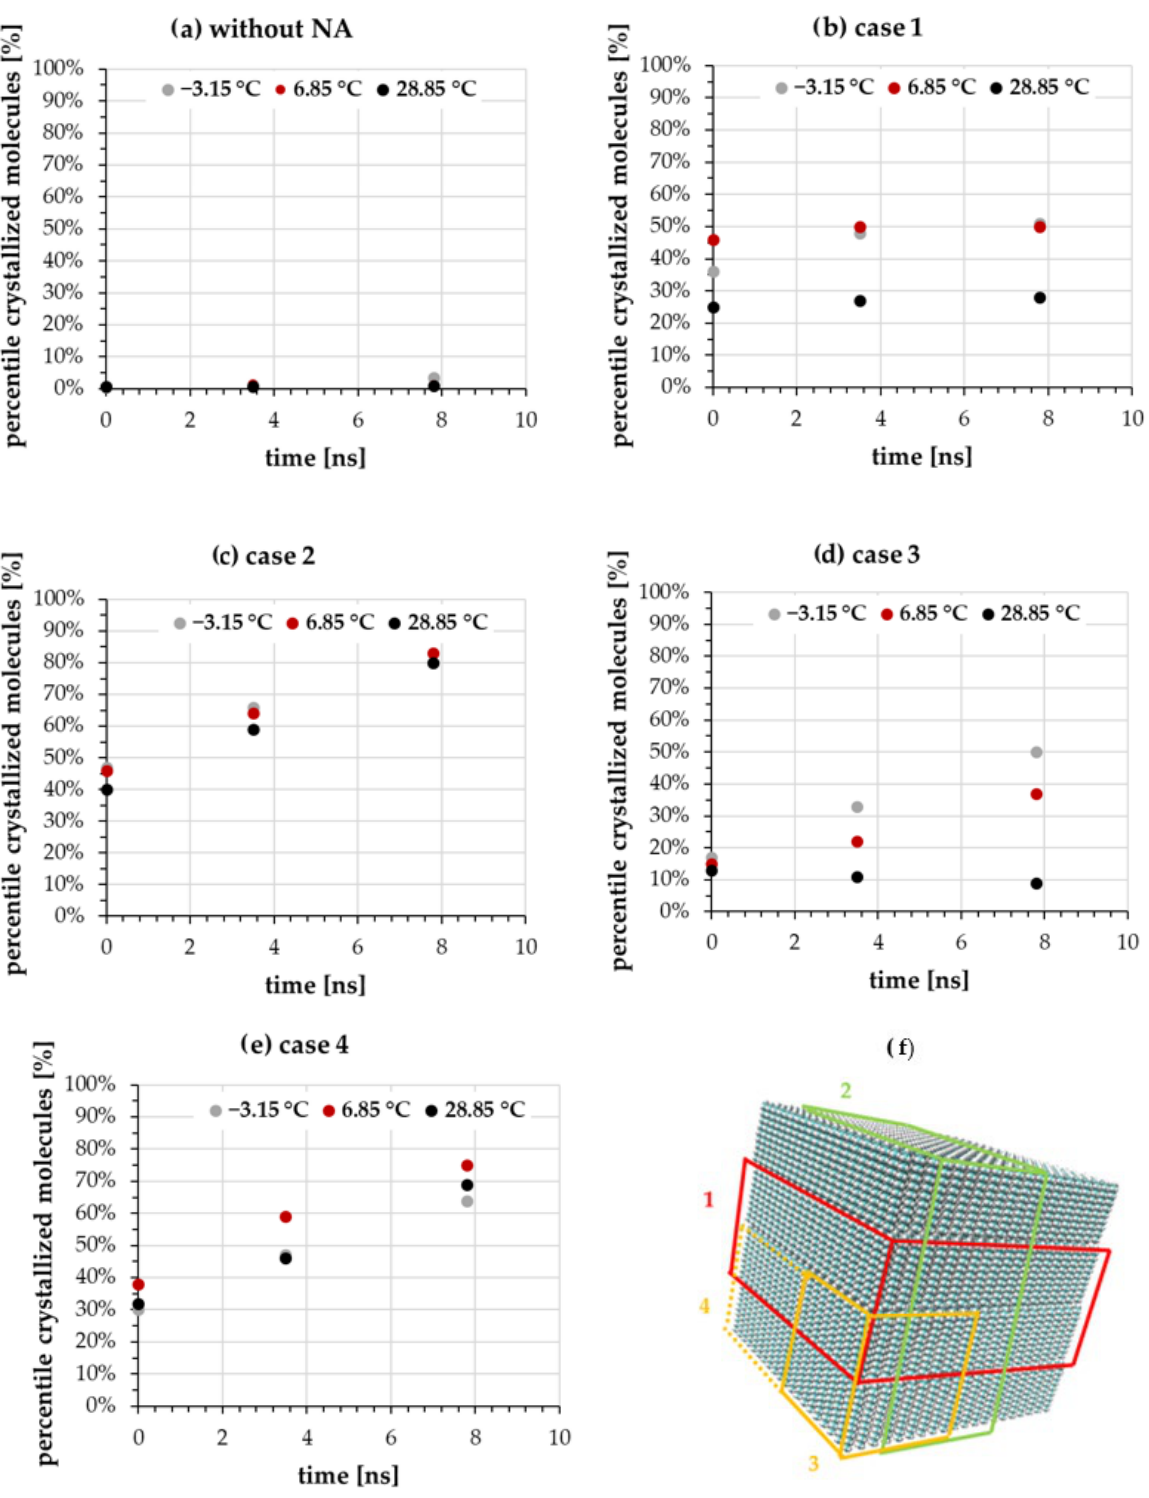
Figure 3. Percentile of crystallized C18 molecules in simulation box for ( a ) no NA, ( b ) Na with a surface consisting of chain ends, ( c ) NA with surfaces consisting only of chain sides, ( d ) small NA with surfaces of both chain sides and ends and ( e ) a large NA with surfaces of both chain sides as well as ( f ) the simulated C18 system with boxes indicating the initial NA.